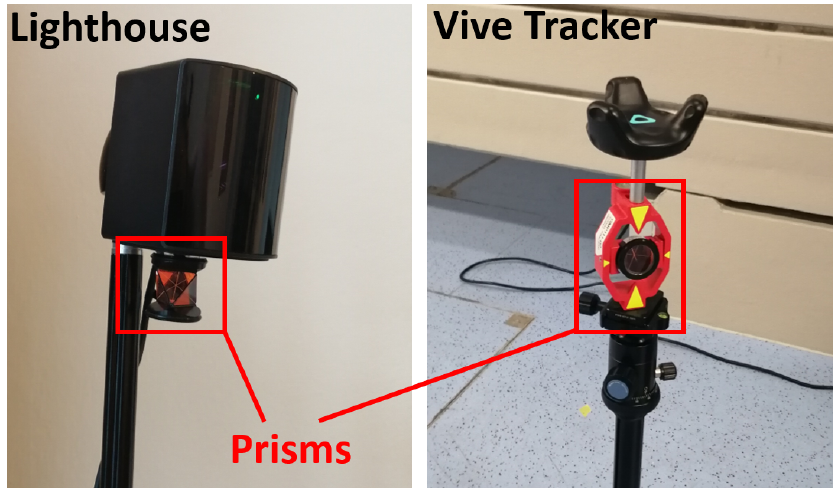
Figure 7. Mounted surveying prisms on the lighthouse and tracker.